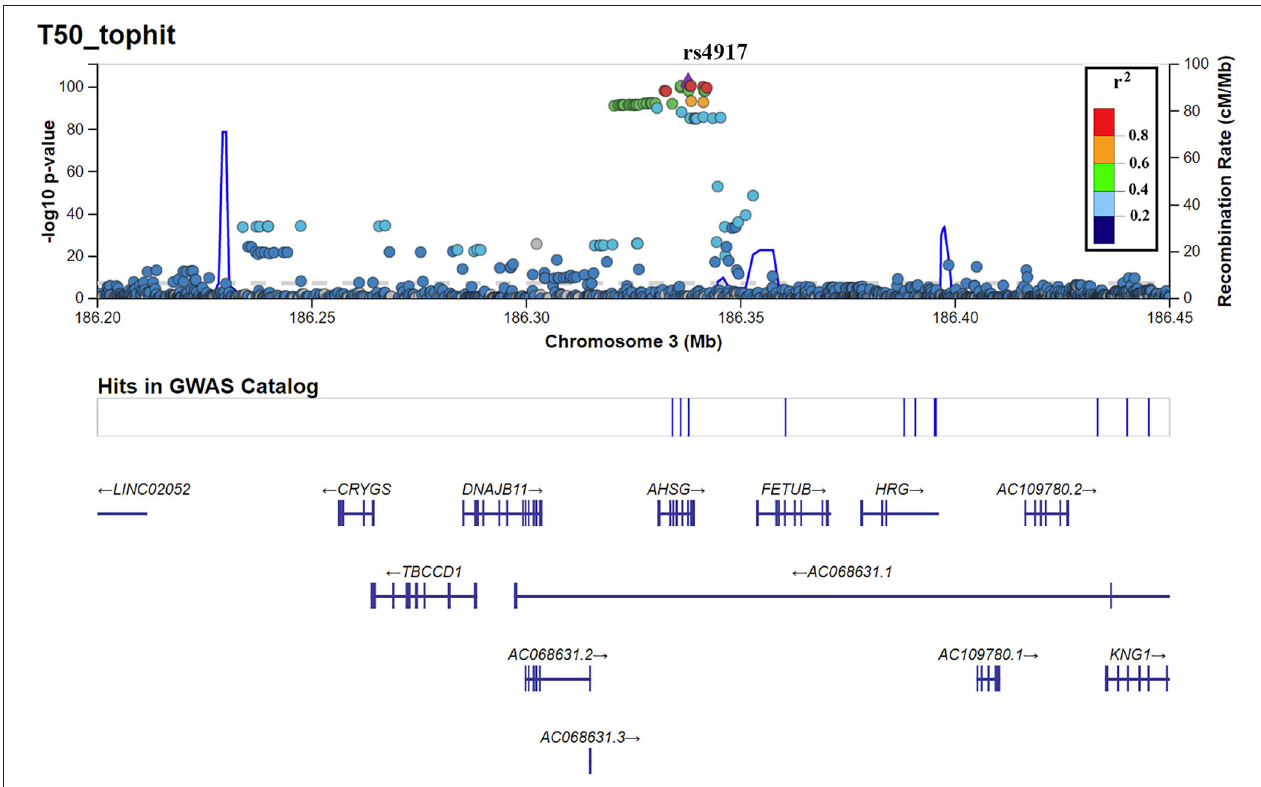
FIGURE 1 | LocusZoom plot of the top hit, rs4917, from the T 50 GWAS.